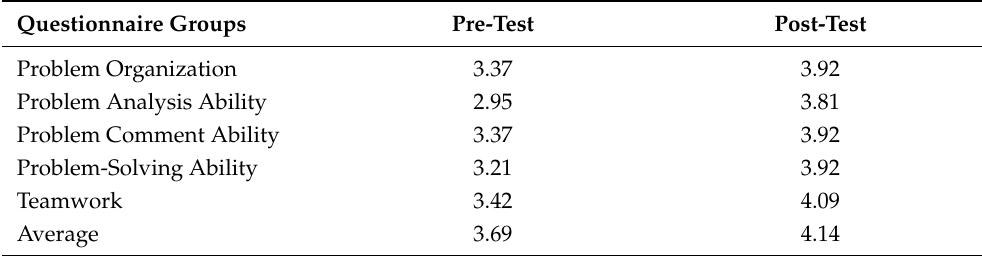
Table 8. Results of the questionnaire groups.